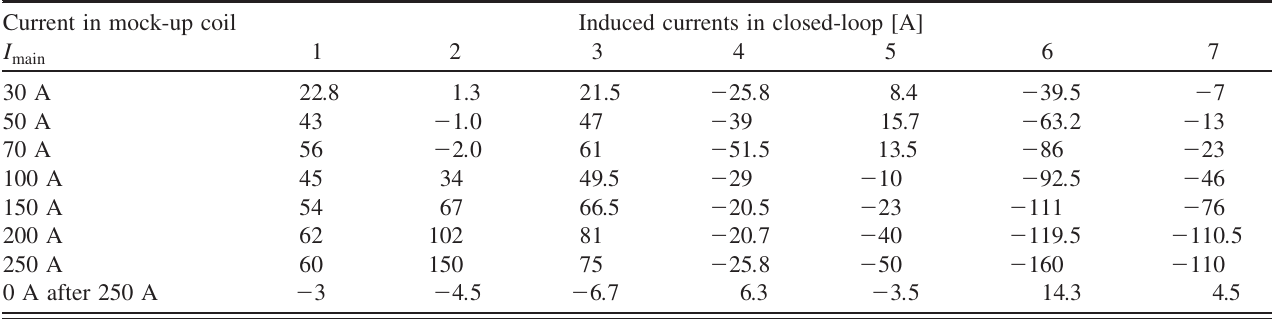
TABLE I. Simulated currents in the seven YBCO loops as a function of the current in the undulator mock-up. The error is approximately (cid:4) 10% .